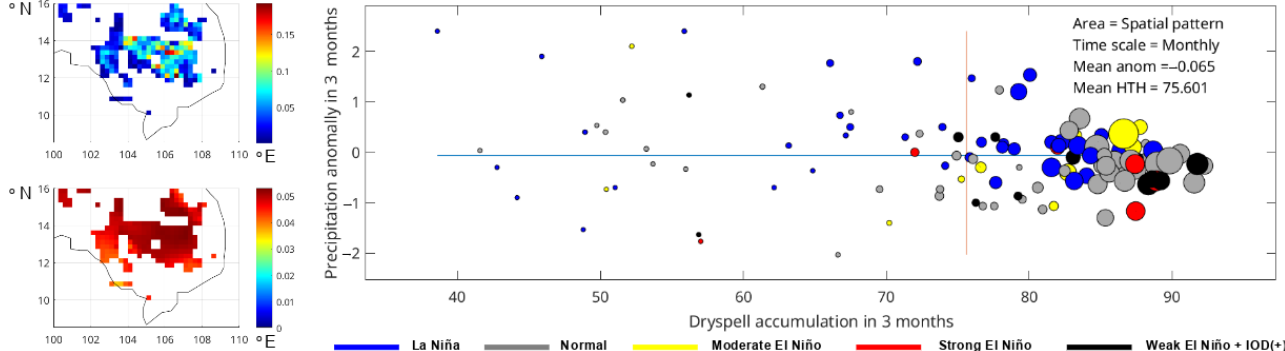
Figure 5. Cambodia—spatial graph of hotspots ( top ) and dry spells ( bottom ) as well as bubble plot of the monthly fire events for all categories. Blue and orange lines represent average value of respective variables. Size of the bubble represents the number of hotspots for each particular month. Extracted from first mode of SVD with 96% of SCF value.